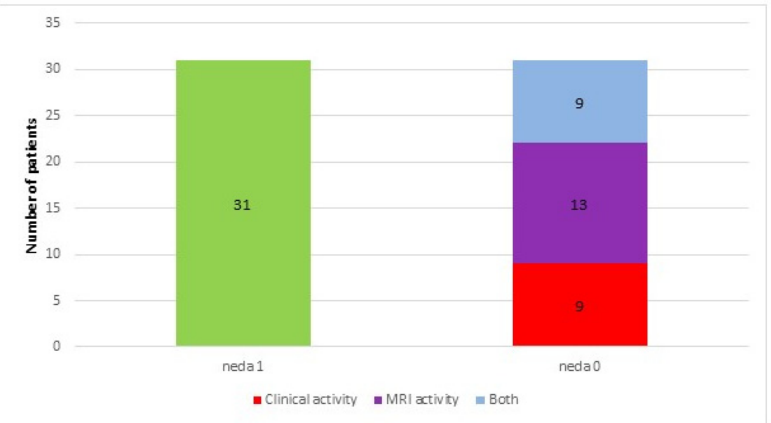
Figure 2. Numbers of patients who had no evidence of disease activity (NEDA 1) or presented with clinical and radiological activity measures (NEDA 0) within a year of